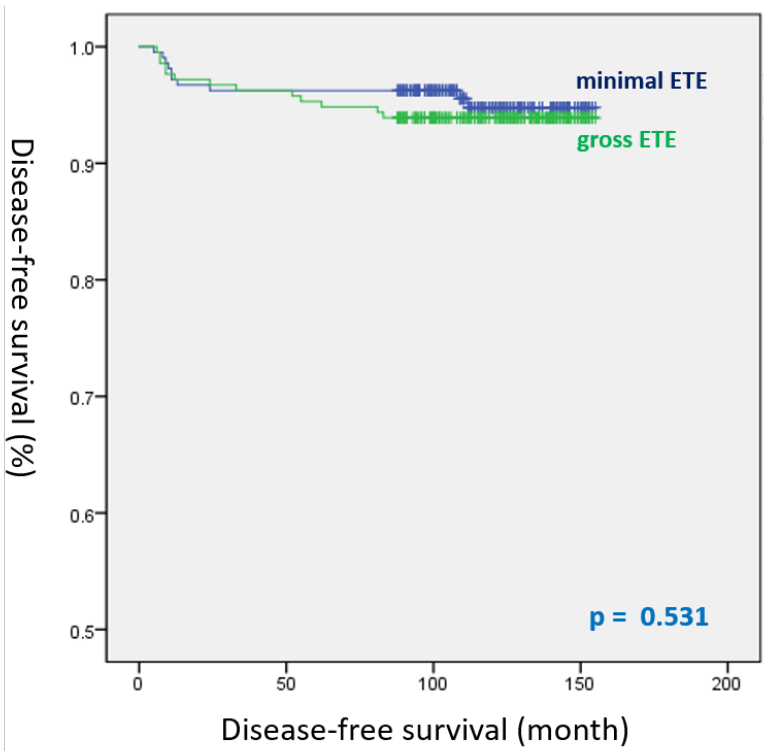
Figure 2. Disease-free survival curves of the mETE and gETE groups after propensity score match- (log-rank p = ing (log-rank p = 0.531).